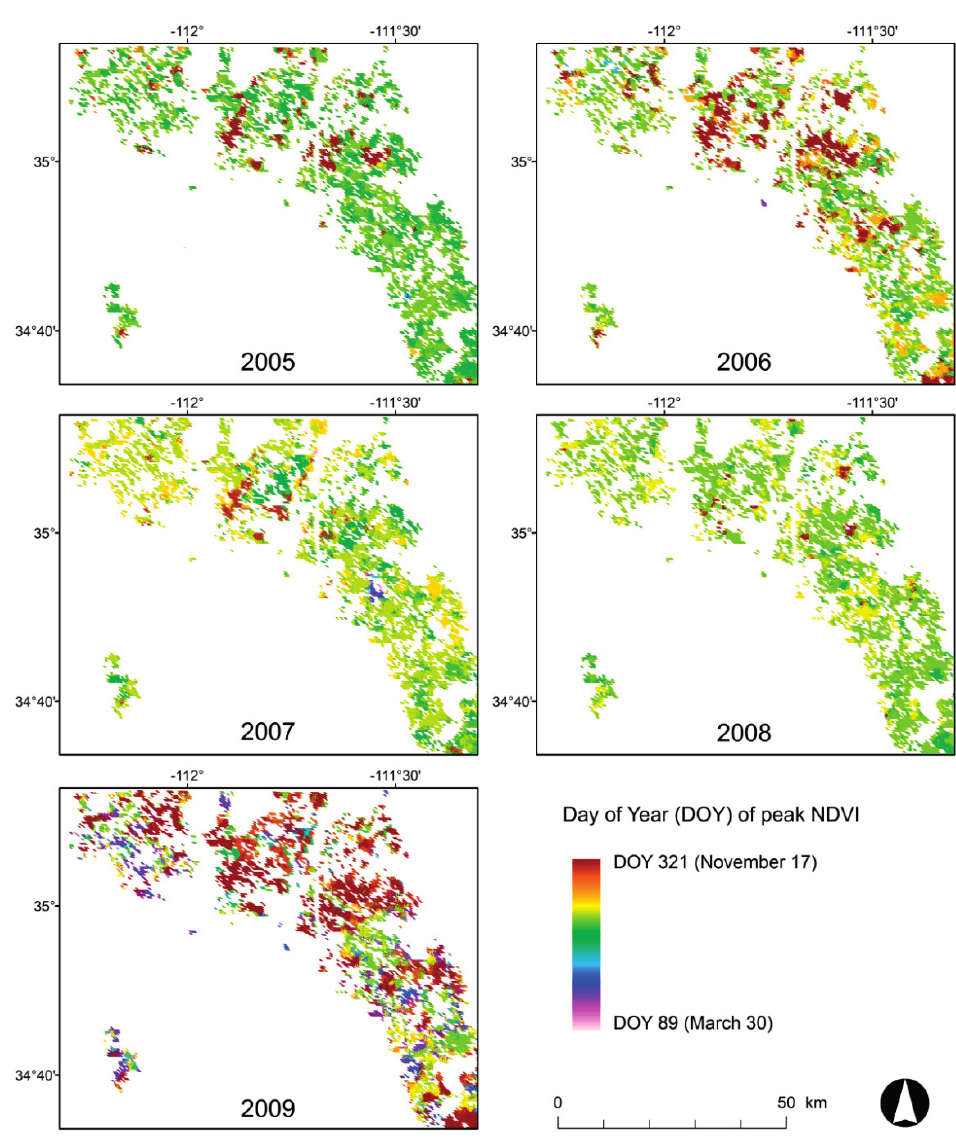
Figure 8. Maps of the annual timing of peak NDVI recorded in each of the 1.3 million STARFM pixels from 2005 to 2009. Early-season pixels in 2007 (represented in blue) were excluded from the overall statistical analysis due to the presence of fire in that